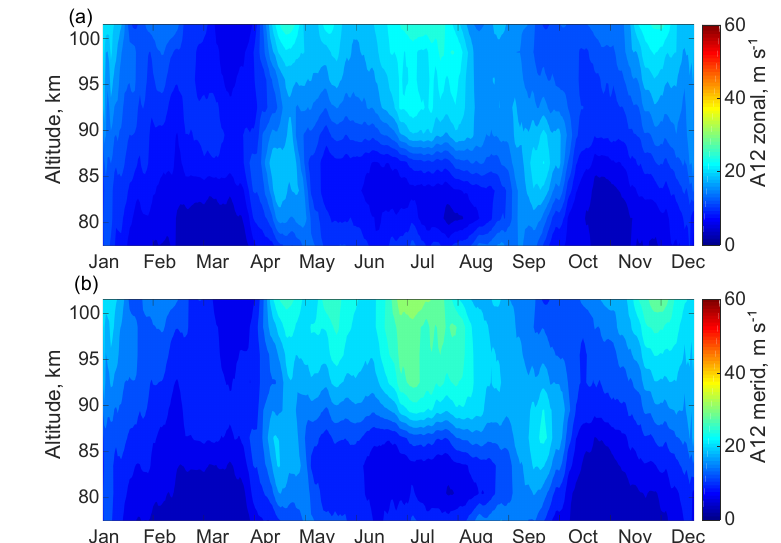
Figure 3. Amplitudes of semidiurnal tides at high latitudes (corresponding to Andenes) extracted from the KMCM simulation. Panels (a, b) correspond, respectively, to the zonal and meridional components.